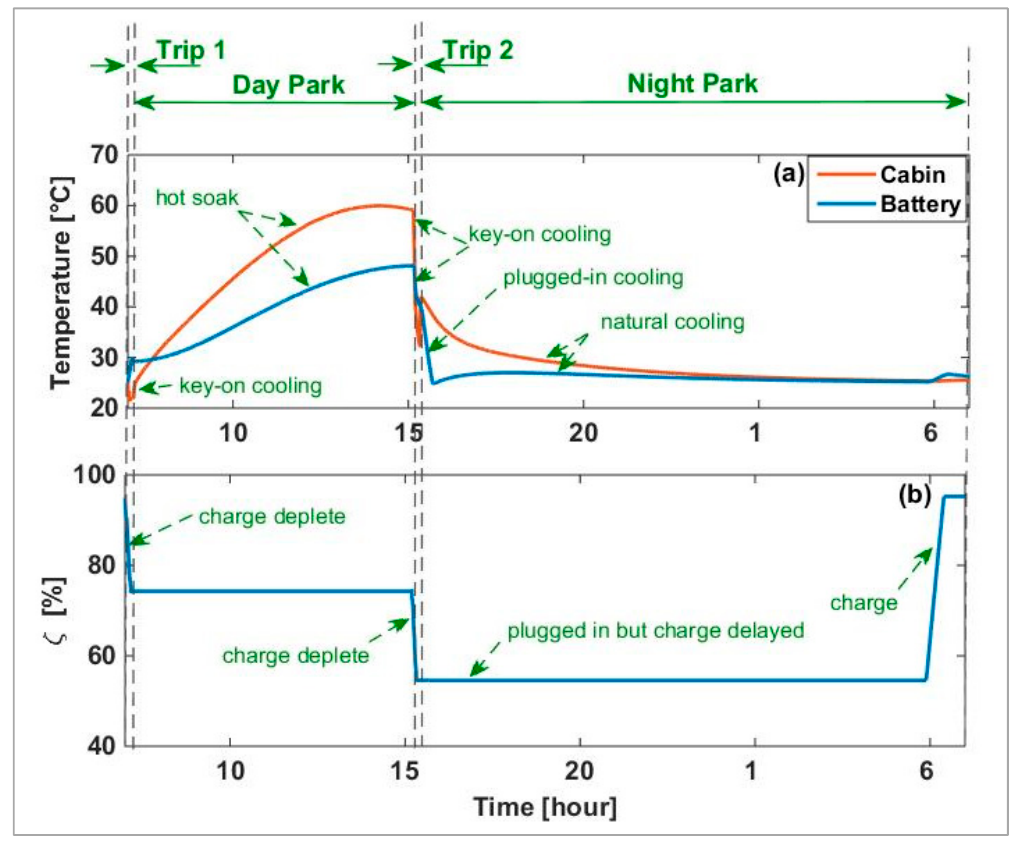
Figure 4. Daily profile of ( a ) the temperature of the cabin and the battery; and ( b ) the battery SoC in summer.